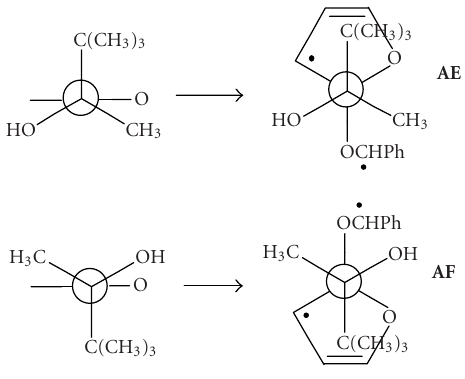
Figure 15: Possible conformations of the biradical intermediate from the reaction of 1-methyl-1- t -butyl-1-(2-furyl)methanol with